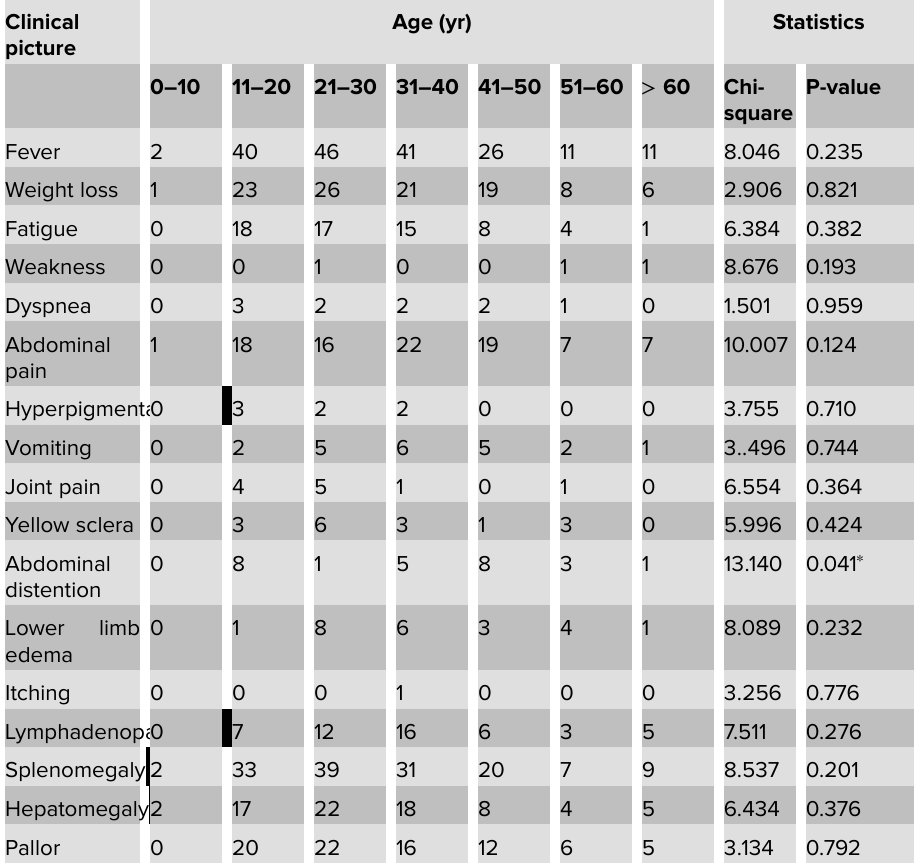
Table 7: Association between clinical presentations of patients diagnosed with VL at the TDTH and the corresponding age